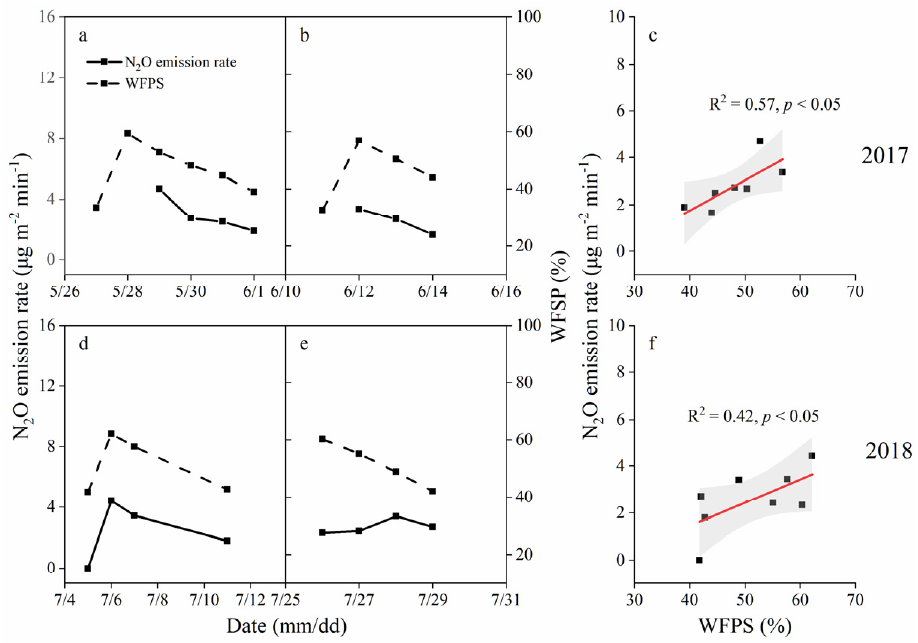
Figure 2. Variation of N 2 O emission rates and WFPS after irrigation under black plastic film mulching treatment in 2017 ( a , b ) and 2018 ( d , e ), and linear correlation between N 2 O emission rates and WFPS in 2017 and 2018 ( c , f ).